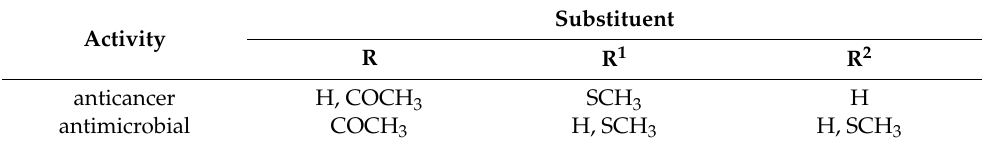
Table 2. The dependence of the activity of alkaloids 130 – 132 on the type of substituents.